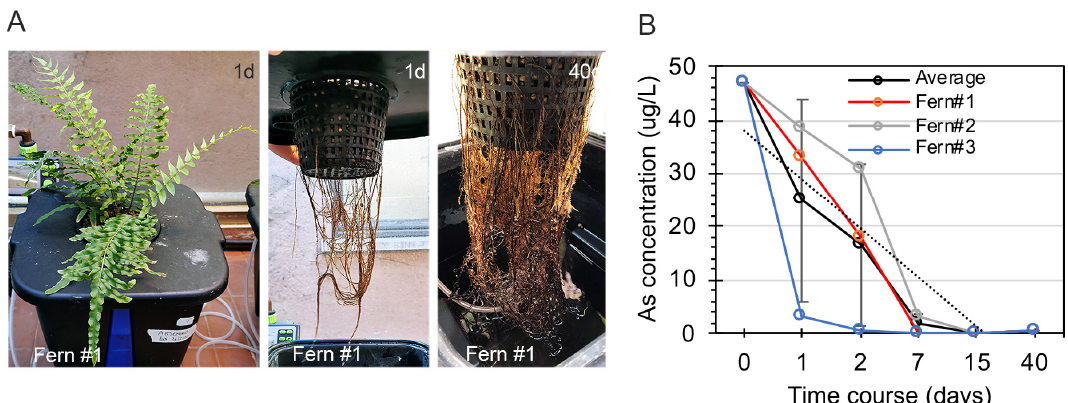
Figure 6. Phytofiltration experiment cycle 2. ( A ) Ferns from cycle 1 were placed in individual buckets filled with 15 L of naturally As-contaminated groundwater. Fern 1 is shown after one day (left panel) and the fronds and roots of Fern 1 after one day (central panel) and 40 days (right panel) on As treatment. ( B ) The amount of arsenic in the water at different timepoints is reported for each fern at the indicated times from one day to 40 days: Fern #1 red line; Fern #2 grey line; Fern #3 blue line. Average value ± SD is indicated by the black line.